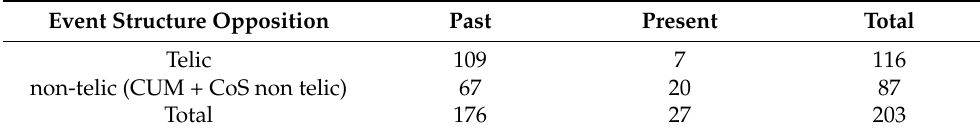
Table 7. Temporal anchoring of telic vs. non-telic utterances in all temporal contexts. Event Structure Opposition